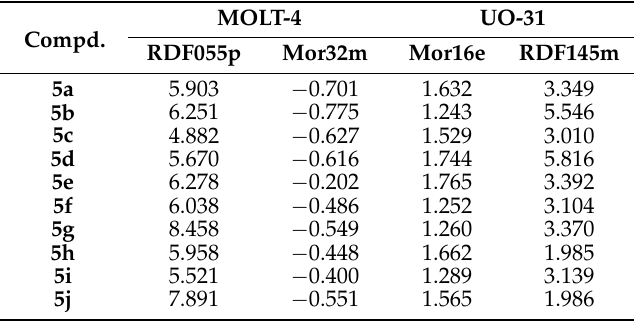
Table 3. Molecular descriptors along with their values and interpretation used for developing QSAR equations. RDF055p —Radial Distribution Function—055/weighted by polarizability; Mor32m —signal 32/weighted by mass; Mor16e —signal 16/weighted by Sanderson electronegativity; RDF145m —Radial Distribution Function—145/weighted by mass.